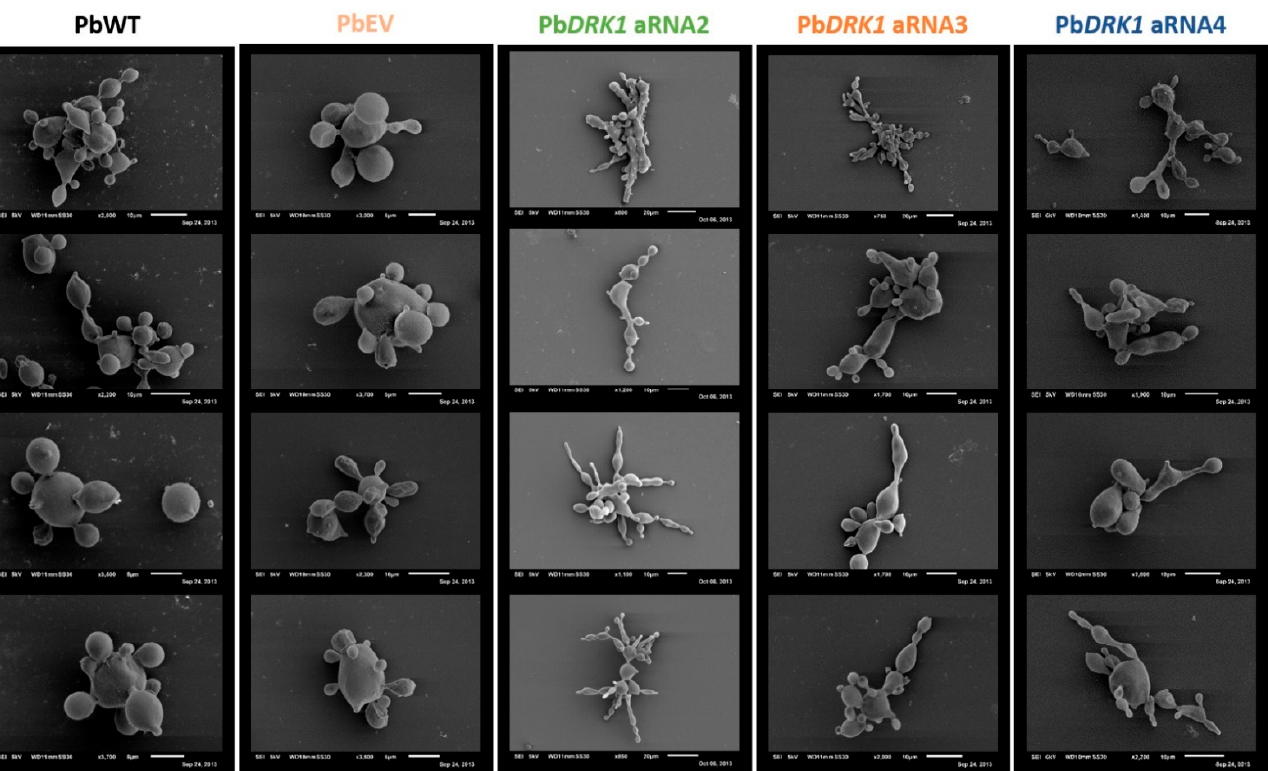
Figure 7. DRK1 is required for normal yeast morphology. The panel illustrates the morphological phenotype of PbWT, PbEV, Pb DRK1 aRNA2, Pb DRK1 aRNA3, and Pb DRK1 aRNA4 yeast cells with scanning electron microscopy, all strains cultured for 72 h in liquid BHI medium (1% glucose) at 37 °C (150 rpm). Scale bars are indicated in each figure.